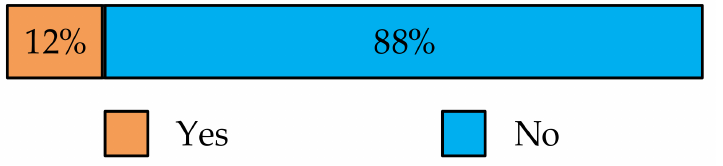
Figure 4. Distribution of “Yes” and “No” in answering the question “Do you think CPQ should be issued if the user issues CBQ in advance?